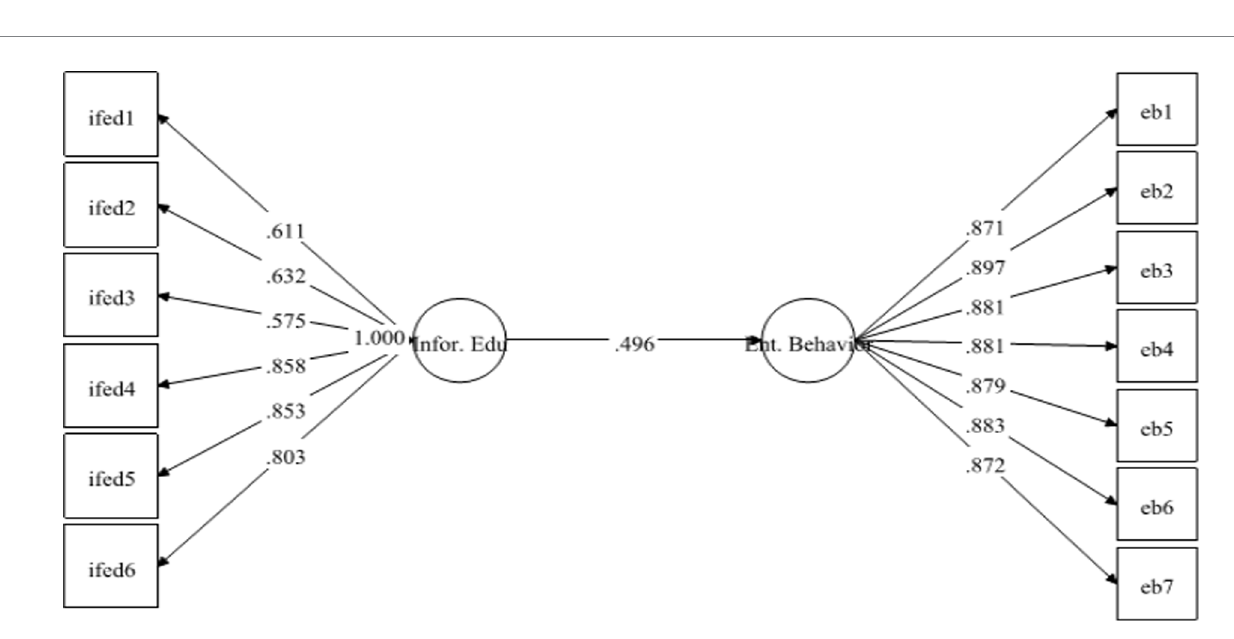
FIGURE 2 Direct relationship between informal education (Infor. Edu) and entrepreneurial behavior (Ent.